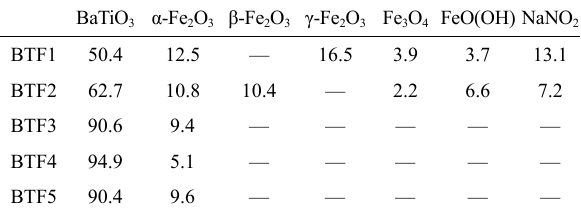
Table 1 Mass percent of all detected phases in the samples BTF1–BTF5